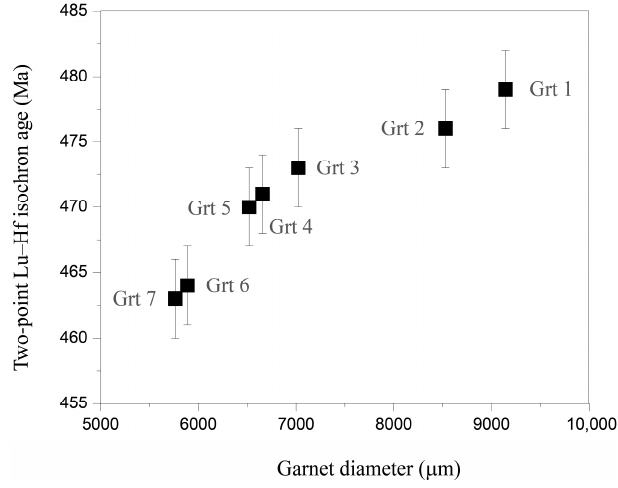
Figure 5. Correlation between the garnet diameters and the corresponding Lu–Hf date.